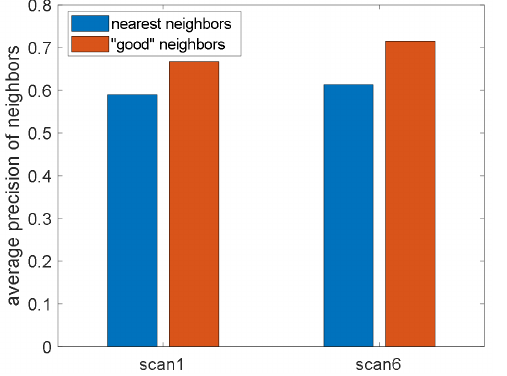
Figure 5. Visualization of both nearest neighbors and “good” neighbors on two pairs of images in the DTU dataset. The top row is from scan1 and the bottom row is from scan6. The reference correspondence is in yellow. Correct and wrong correspondences are in green and red, respectively.